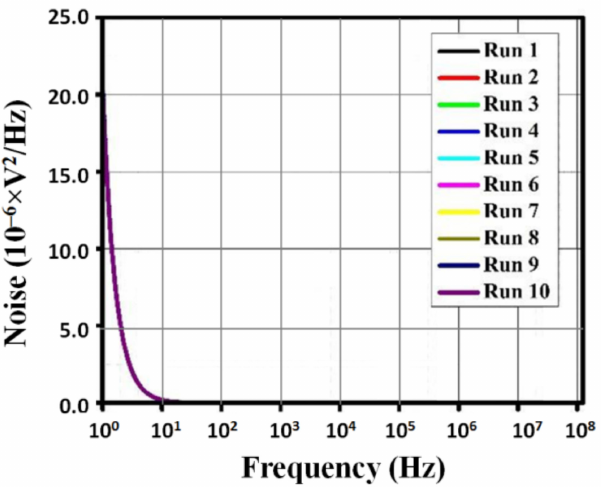
Figure 12. Noise vs. frequency plot after results from ANN-assisted goal attainment method.